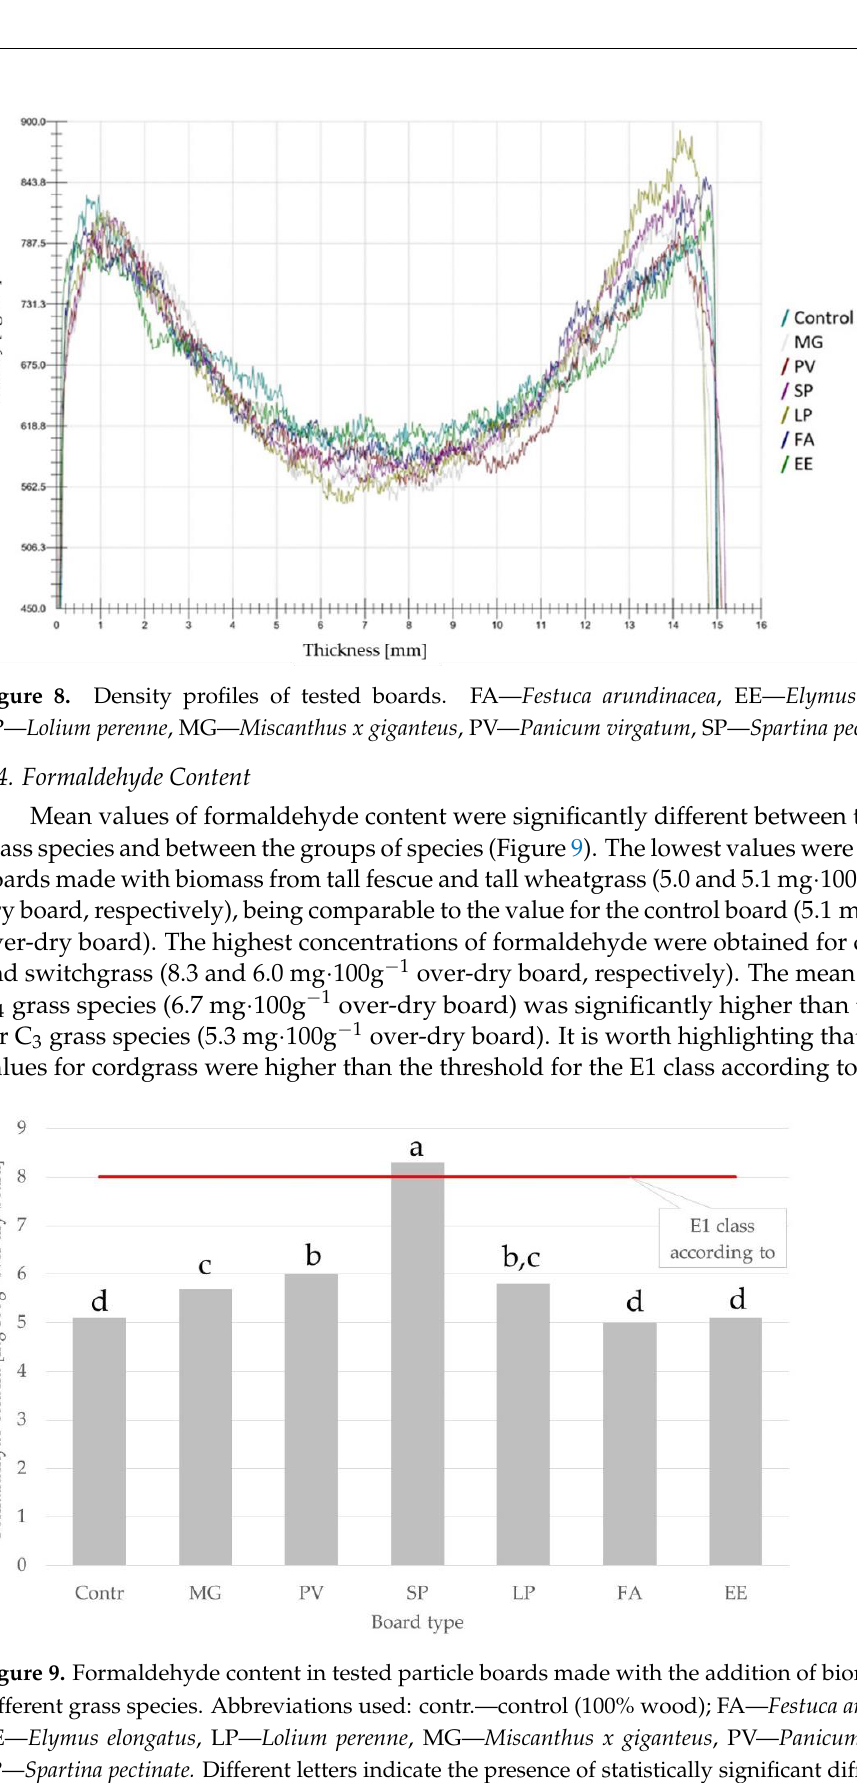
11 of 16 Figure 7. Density of manufactured panels. Abbreviations used: contr. — control (100% wood); FA — Festuca arundinacea , EE — Elymus elongatus , LP — Lolium perenne , MG — Miscanthus x giganteus , PV — Panicum virgatum , SP — Spartina pectinate. No statistically significant difference among the various boards was detected by one-way ANOVA. The density profiles of the tested boards (Figure 8) were found to be nearly symmet- rical on both sides along the central board thickness, which is typical in the case of such experiments [21,56,57]. The density was very low at the surface of each board but in-